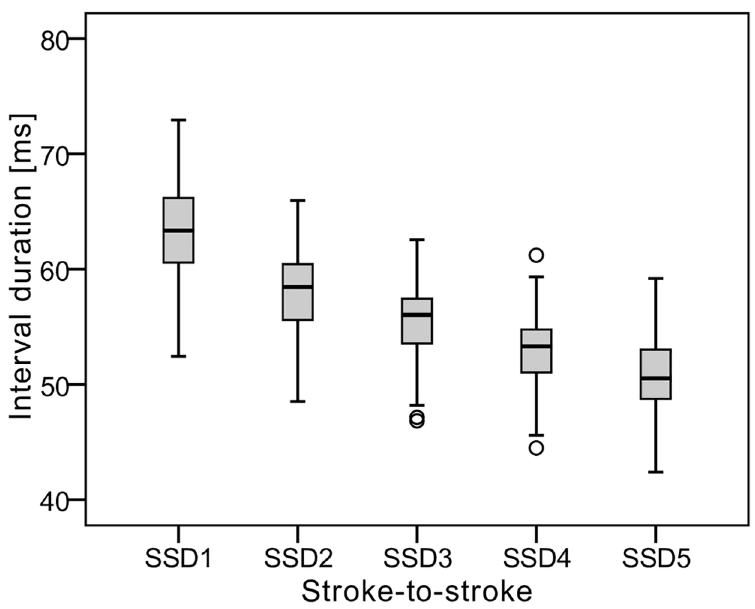
Fig 2. Interval duration between succeeding strokes within a roll. First five stroke-to-stroke durations (SSD1-SSD5) and minimal stroke-to-stroke duration within a roll (SSDmin) are given. Figure based on average values of 41 drumming individuals.